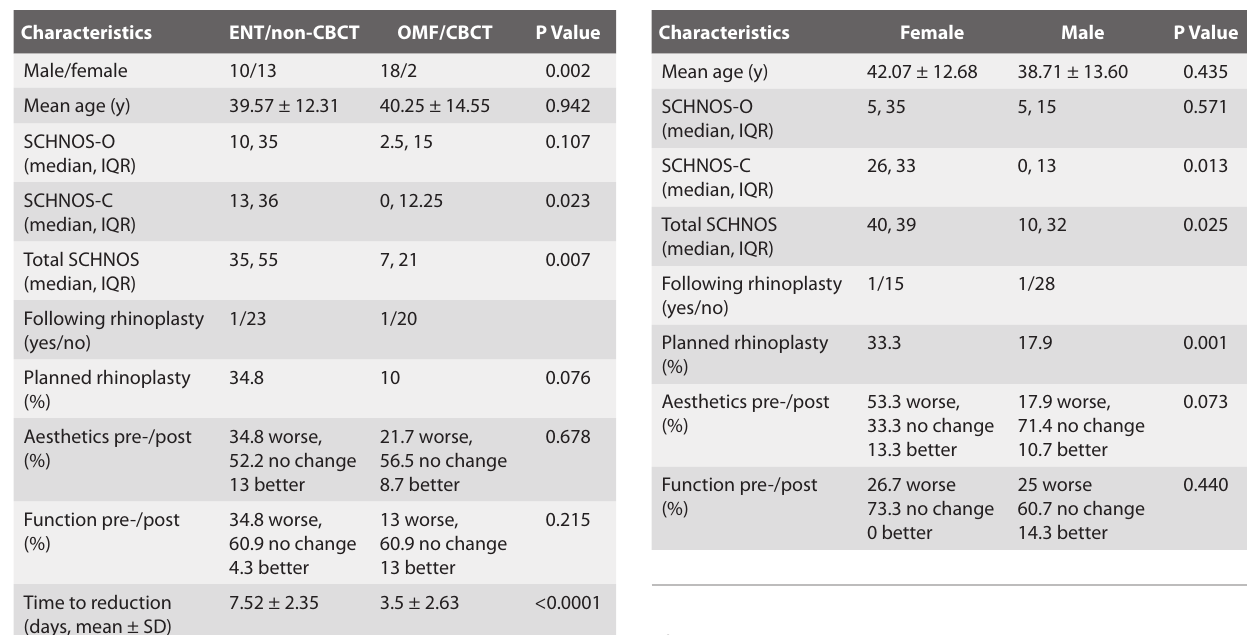
Table 3. Comparison of the measurements between female and male patients of both groups (ENT/non-CBCT and OMF/CBCT)